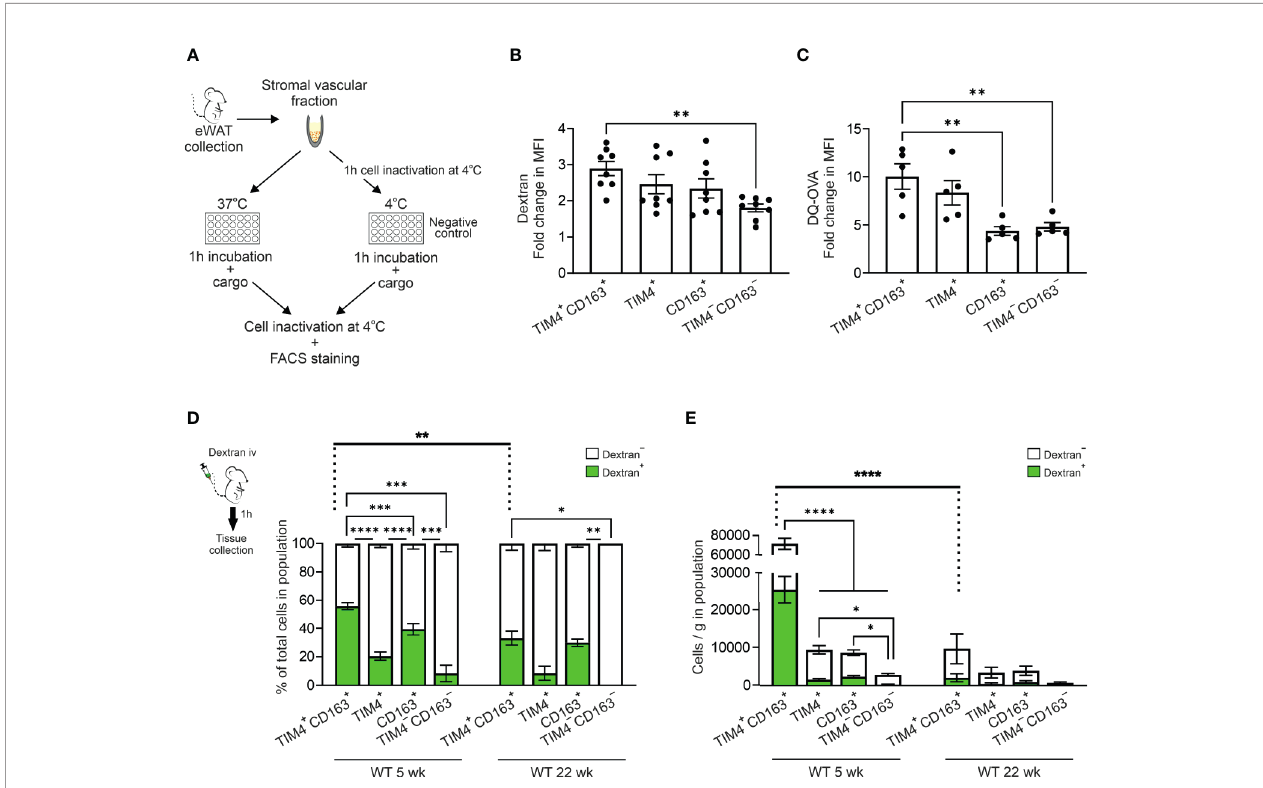
FIGURE 6 | TIM4 + CD163 + and TIM4 + ATMs are ef fi cient in scavenging and have an antigen processing capacity. (A) The experimental setup for measuring the in vitro engulfment of 0.5 µm fl uorescent beads, 500kDa fl uorescent dextran, or DQ ovalbumin by different macrophage subtypes isolated from eWAT of 5 or 30- week-old wild type (WT) mice. (B) Endocytosis of dextran by the different macrophage subpopulations [fold change in mean fl uorescence intensity (MFI) at 37°C versus background at 4°C]. (C) Antigen processing capacity of the different macrophage subpopulations (fold change in MFI of DQ-OVA at 37°C versus background at 4°C). (D) Scavenging of dextran in vivo . The experimental setup for studying scavenging (intravenously administered fl uorescent 500kDa dextran). The quanti fi cations show the frequencies of dextran positive and dextran negative cells within TIM4 + CD163 + , TIM4 + , CD163 + , and TIM4 − CD163 − ATM populations of 5- and 22-week-old WT mice. (E) Analyses of the absolute numbers of dextran positive and dextran negative cells from (D) The quantitative data are shown as mean ± SEM (* P ≤ 0.0332, ** P ≤ 0.0021, *** P ≤ 0.0002, **** P ≤ 0.0001, one- (B, C) or two-way (D, E) ANOVA with Bonferroni post-hoc test). Each data point represents one mouse in (B, C) Dextran in vivo experiment (D, E) data are from n = 9 (5 wk) or n = 4 (22 wk) mice. All fl ow cytometry data are from 1 ( D for 22 wk, and E for 22 wk) or 2 ( B – E for 5 wk) independent